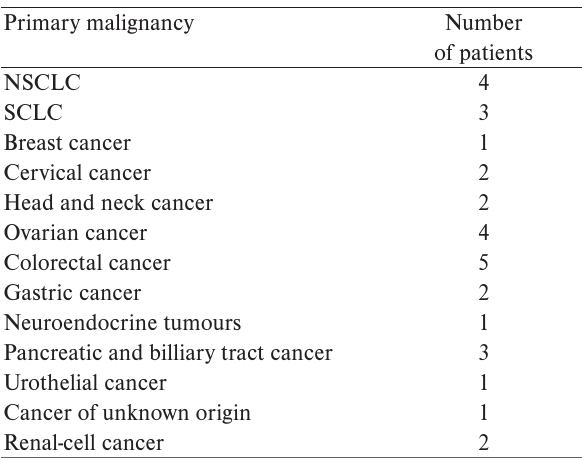
Table 2. Distribution of patients according to primary malig-